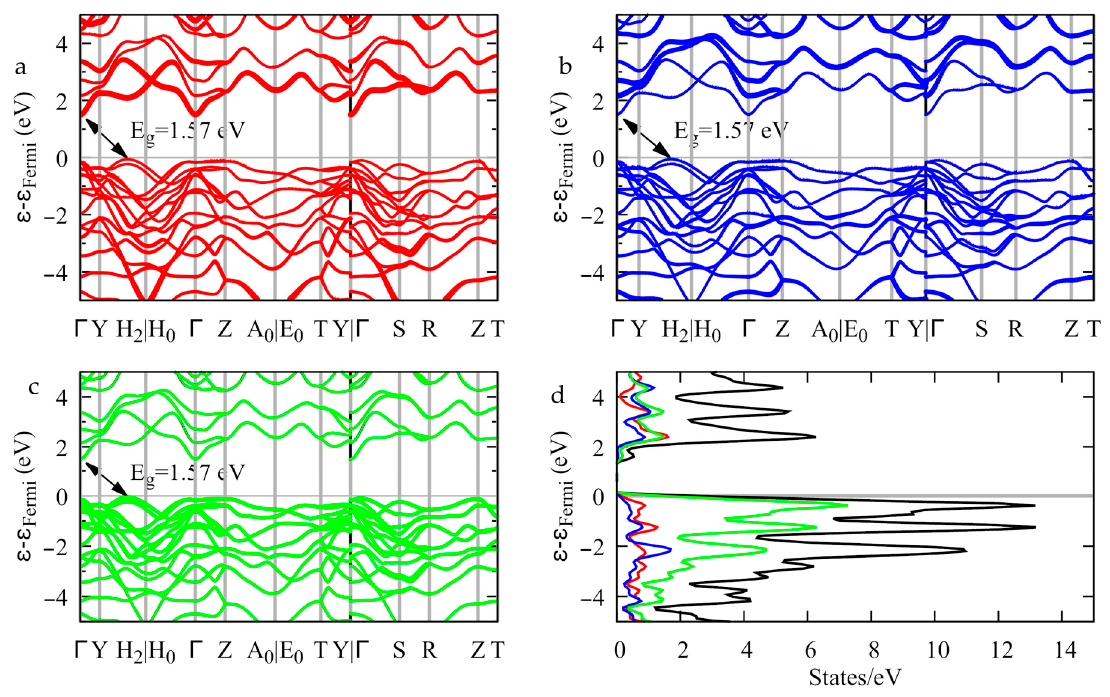
Figure 12. Band structure ( a – c ) and density of states ( d ) of InGaS 3 . The thickness of the bands is proportional to the contribution of the indium ( a ), gallium ( b ), and sulfur ( c ) orbitals.